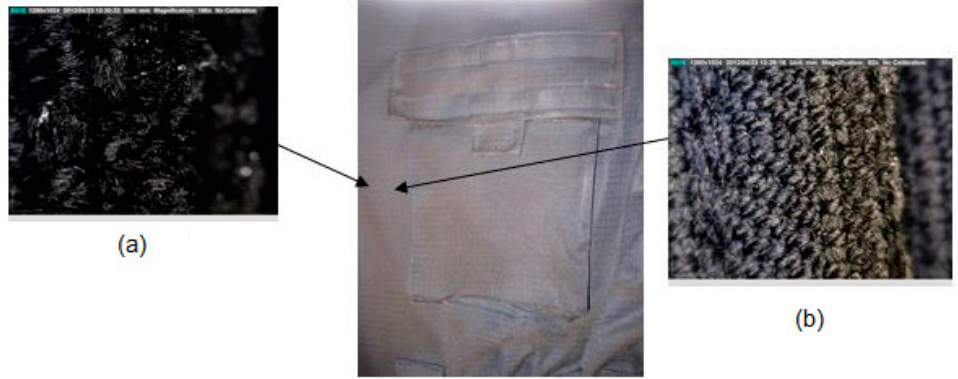
Figure 8. Damage in the area of the upper pocket of the overalls made with a Dino-Lite microscope in two different magnification: ( a ) 184×; ( b ) 60×.